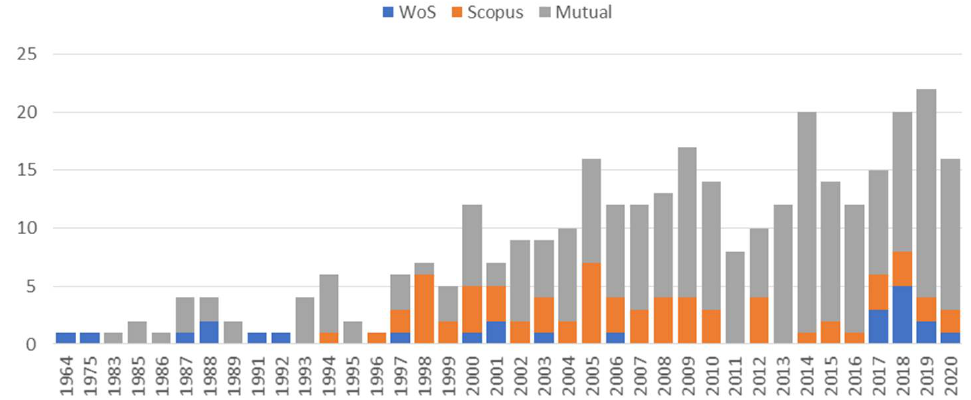
Figure 2. Chronology of the overlapping of articles indexed in WoS and Scopus on the Water Mar- ket.